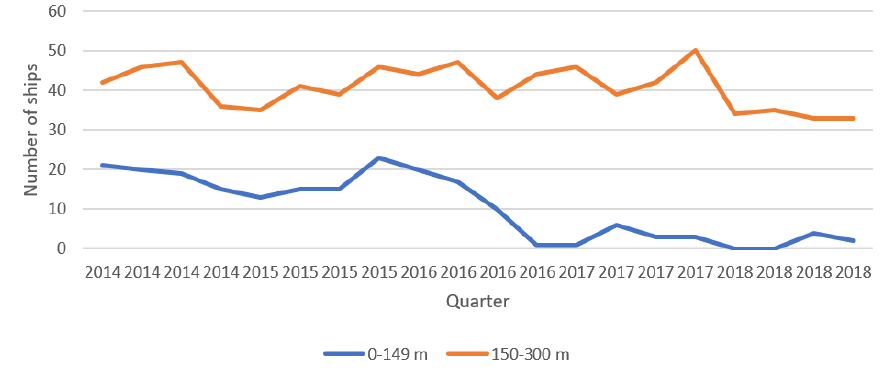
Figure 6. The sizes of ships arriving at the port of Gävle.